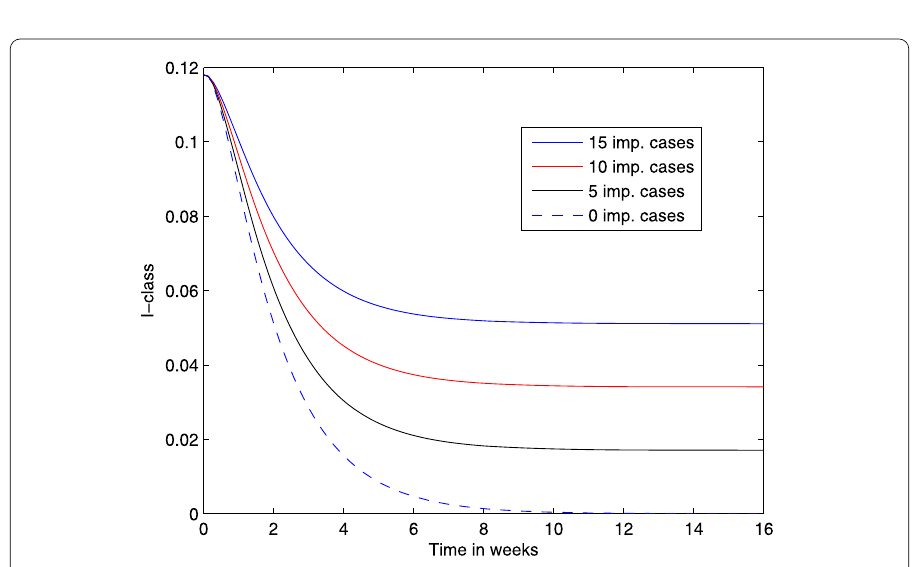
Figure 2 The trajectories over a period of 16 weeks, of the active local infections I for different levels of annual imported infected cases. It is assumed that 95% of newborns are being vaccinated